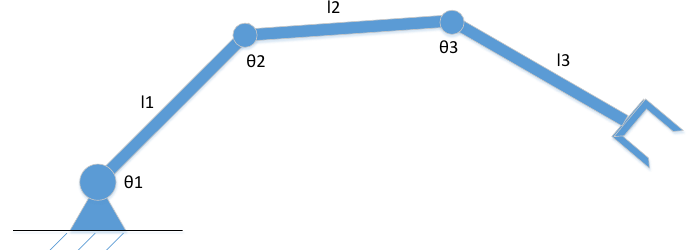
Figure 6. Three-link manipulator.